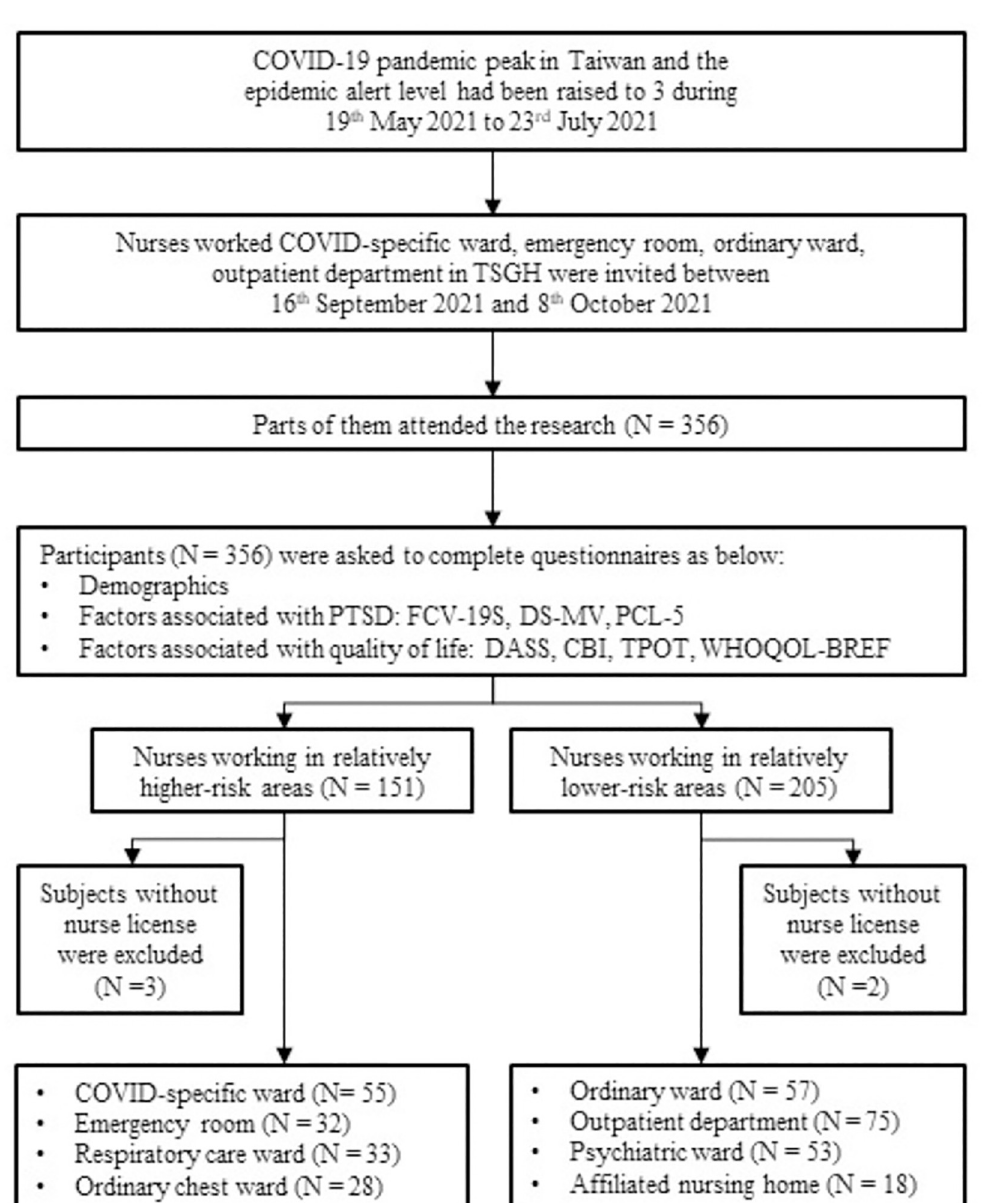
Fig 1. Recruitment and participation of the